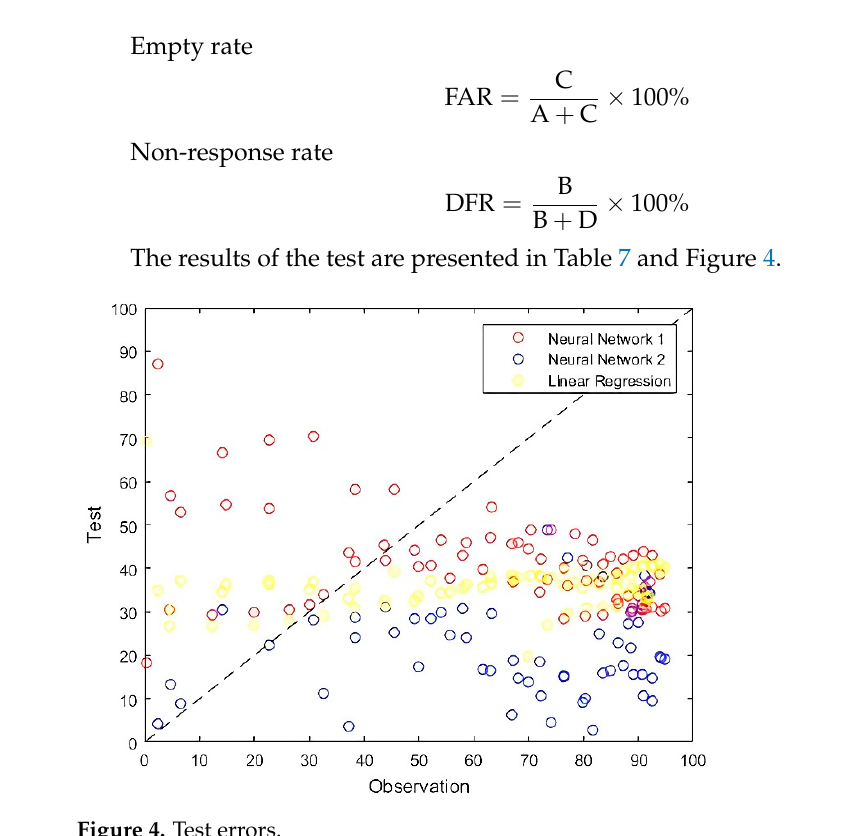
Figure 4. Test errors.